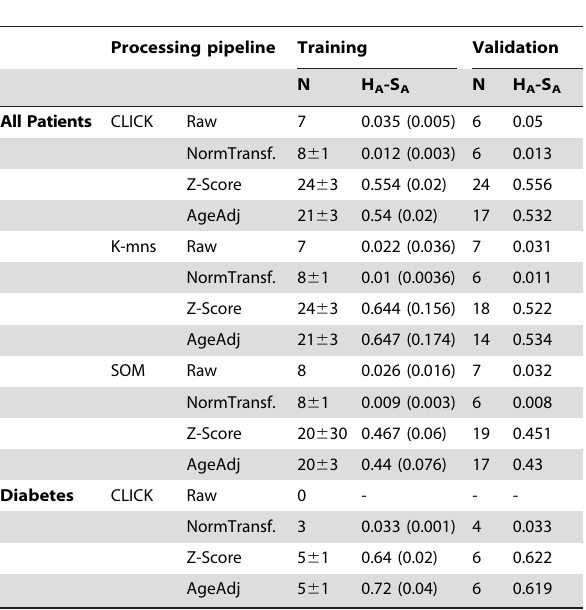
Table 1. The quality of clusters obtained with different pre- processing-clustering pipelines.